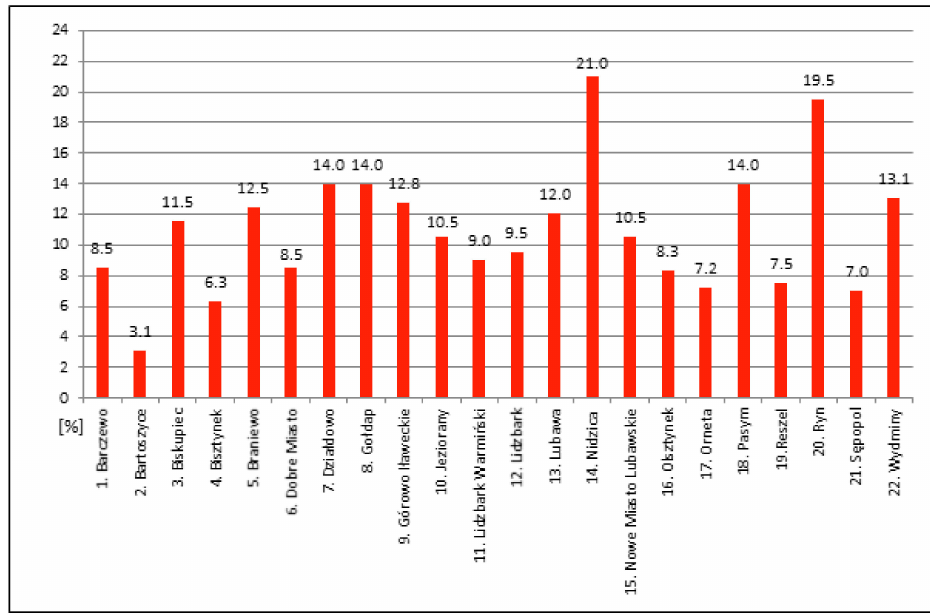
Figure 8. Relative market square area in Polish towns. Source: own